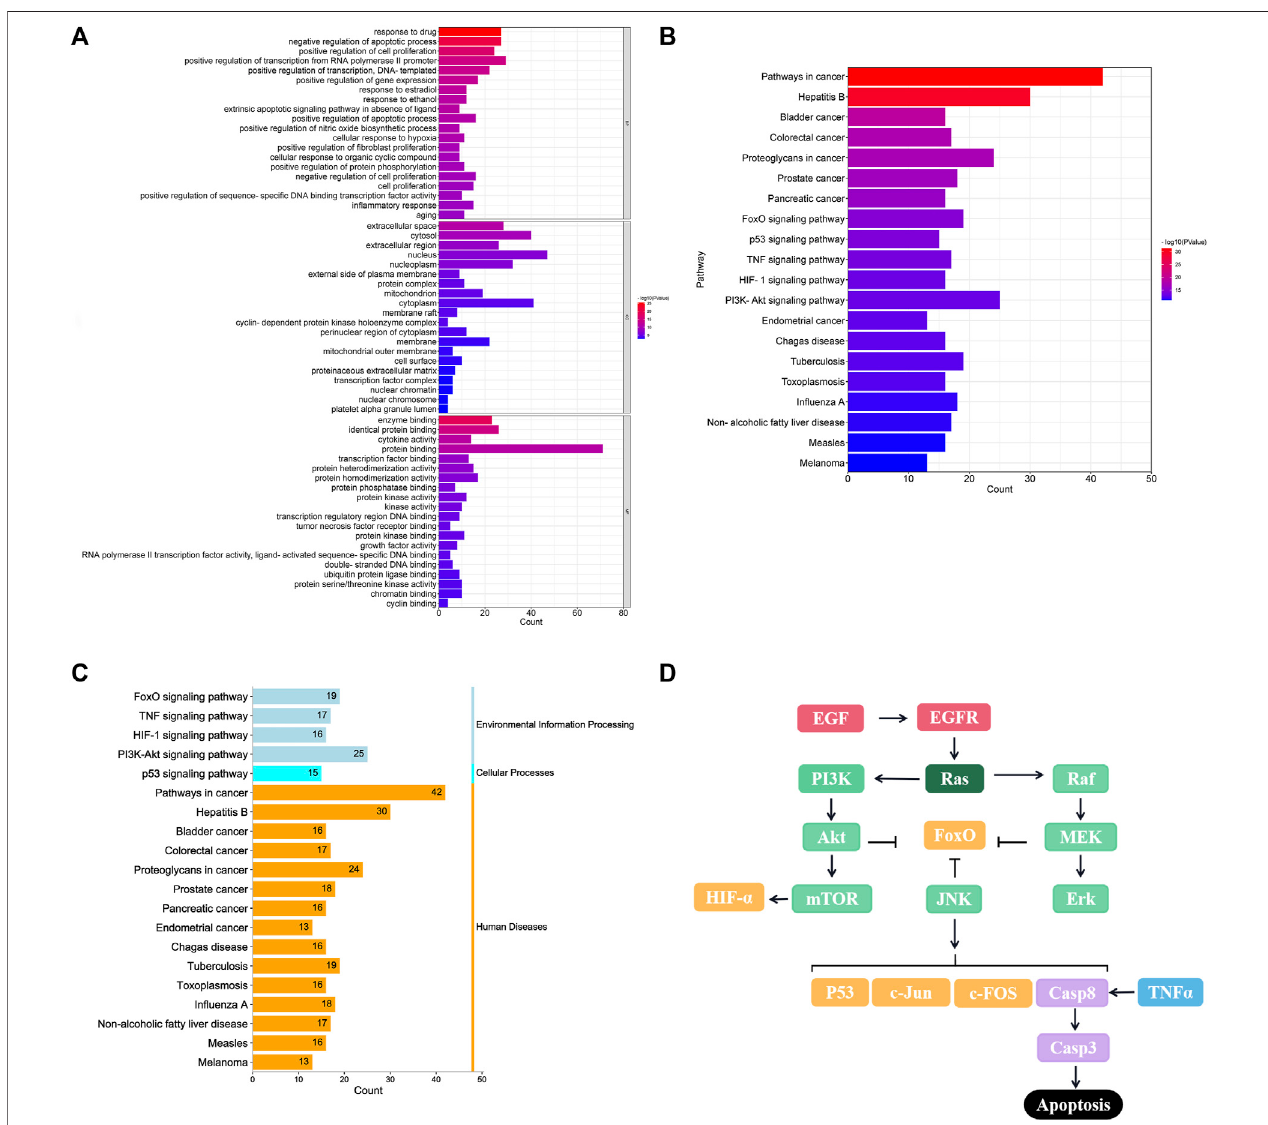
FIGURE 3 | GO and KEGG enrichment analysis of 80 overlapped genes. (A) Top 20 GO enrichment analysis for the functional processes, molecular mechanism, and function; (B) Top 20 KEGG enrichment pathway; (C) Enrichment functional classi fi cation for top 20 KEGG pathways. (D) Crosstalk of key targets and pathways.